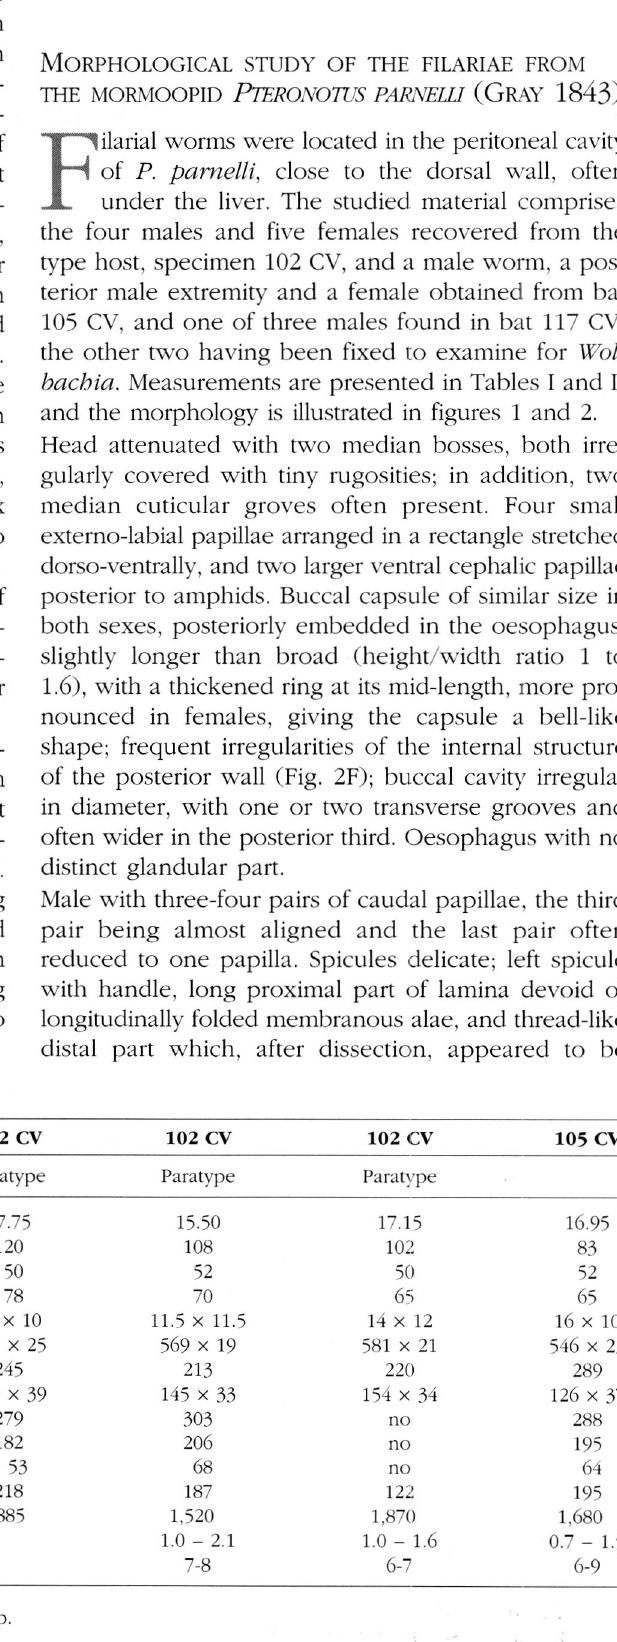
Table I. - Measurements of males of Litomosoides yutajensis n.